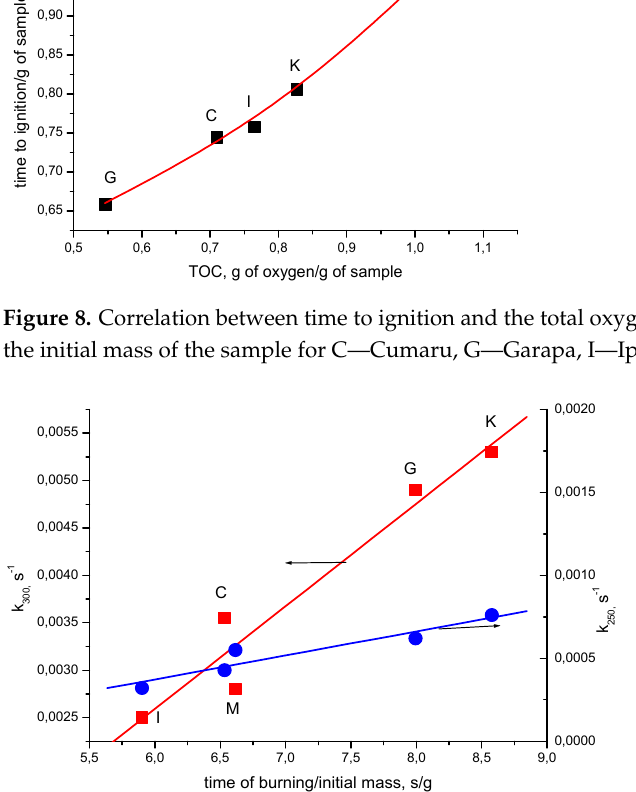
Figure 9. The rate constants at 250 and 300 °C determined from non-isothermal thermogravimetry vs. the total time of burning related to the initial mass of wood C—Cumaru, G—Garapa, I—Ipe, K—Kempas, M—Merbau.